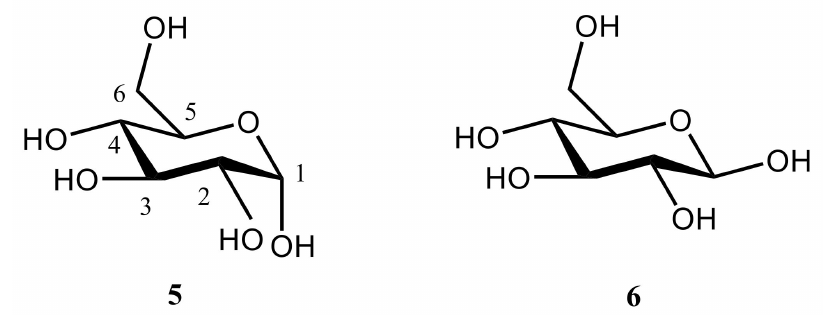
Figure 12. Anomeric forms of D-glucopyranose: α -anomer ( left ); β -anomer ( right